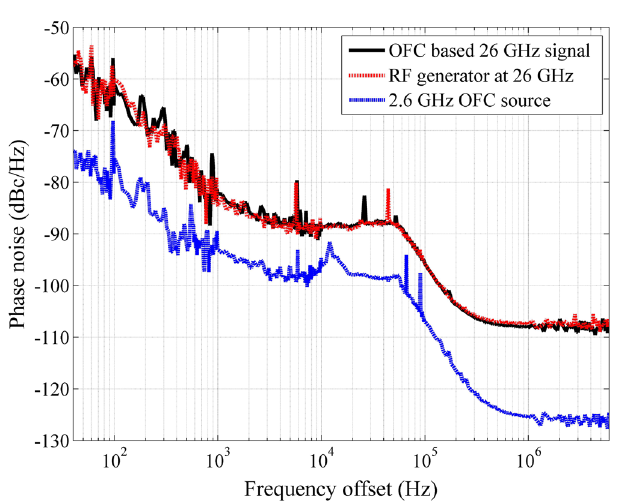
Figure 6. 26-GHz signal generation using the integrated optical frequency comb.